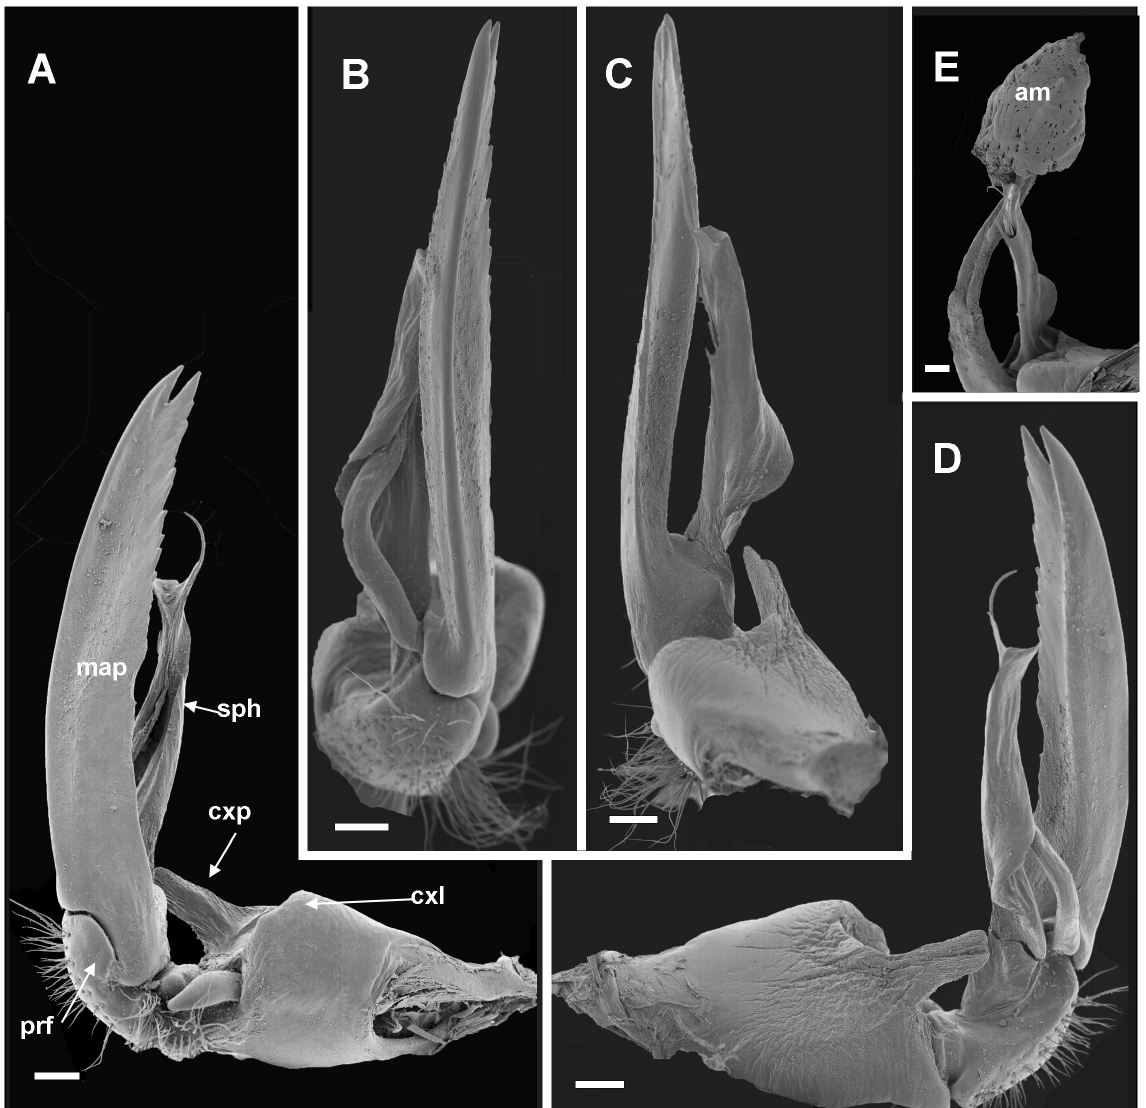
Fig. 23. Eviulisoma coxale sp. nov. A–D . Holotype, right gonopod. A. Mesal view. B. Ventral view. C. Dorsal view. D. Lateral view. E . Paratype from Mito Mitatu, right gonopod, showing lump of amorphous mass on tip of process map. Abbreviations: am = amorphous mass; cxl = coxal lobe; cxp = coxal process; map = mesal acropodital process; prf = prefemur; sph = solenophore. Scale bars: 0.1